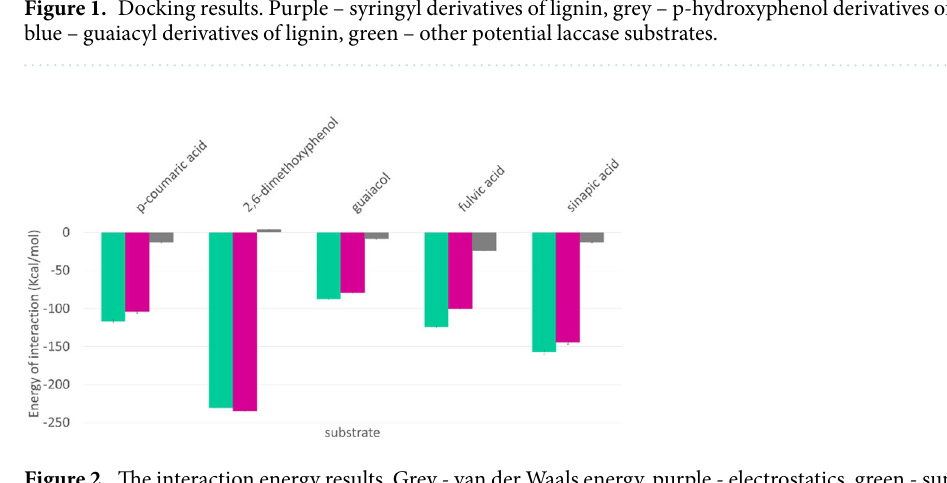
Figure 2. The interaction energy results. Grey - van der Waals energy, purple - electrostatics, green - summary energy of